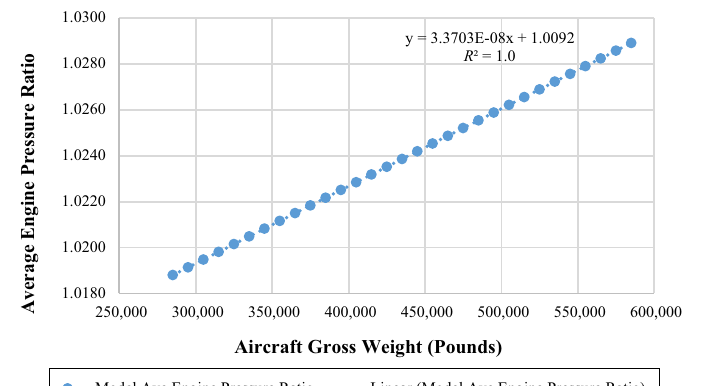
Figure 5. Average